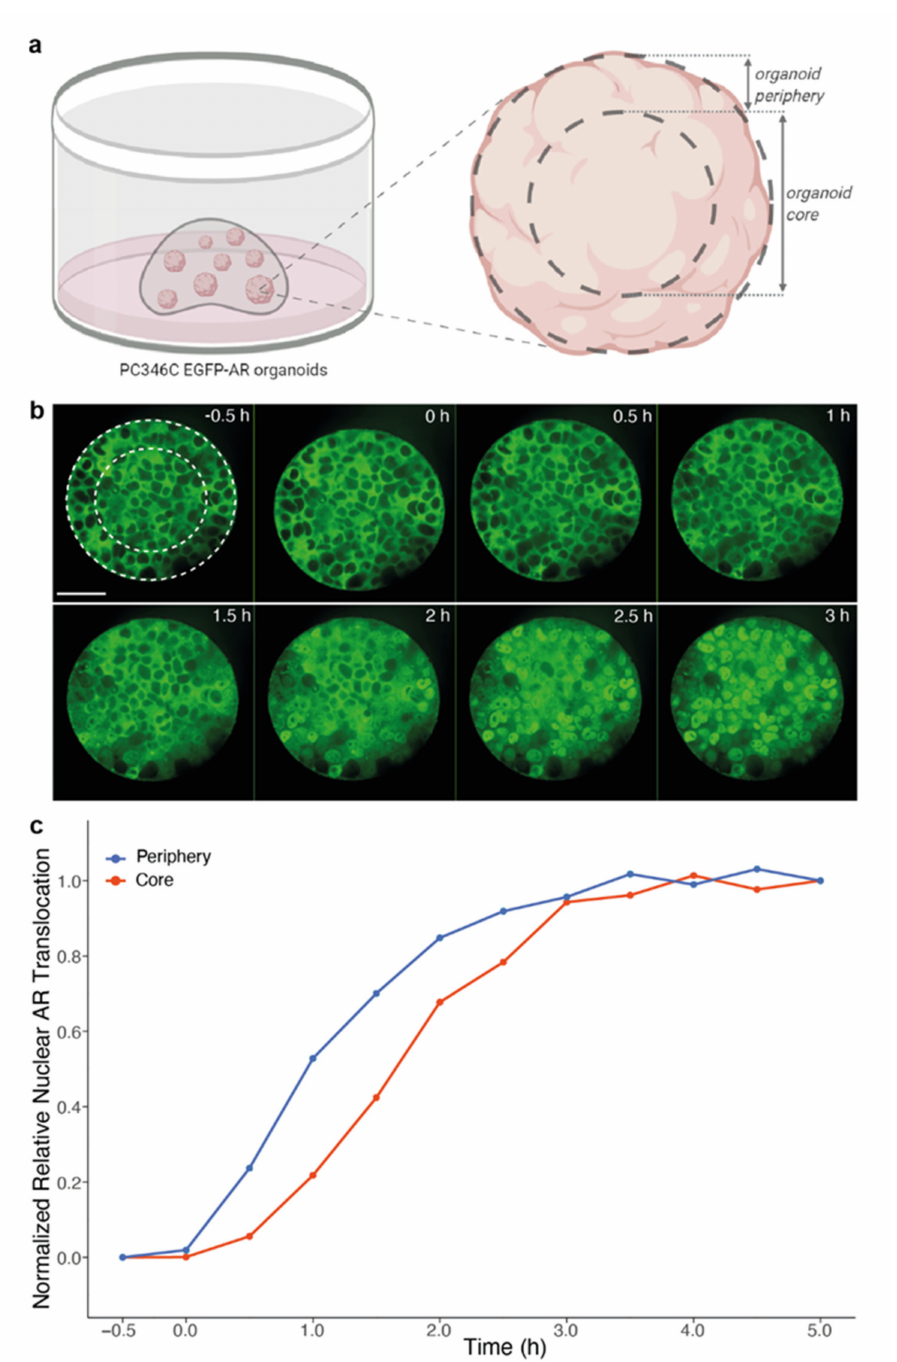
on the X position and Y position. White lines delineate the imaging field. Pink dots depict organoids, red dots are the organoids shown as example in ( c ). Gradient blue circle represents bins applied in ( d ). ( c ) Representative images of androgen-induced AR translocation in a PC346C EGFP-AR organoid located at the center (top panel) or edge (bottom panel) of the Matrigel dome following exposure to synthetic androgen (10 nM R1881). Time after exposure is indicated in the right upper corner of each image. Scale bars indicate 50 µ m. ( d ) Image-based quantification of nuclear AR translocation in organoid cells grouped in nine bins of ~250 µ m, based on the distance from the center of the well as depicted in ( b ). 10 nM R1881 was added to organoid medium at 0 h. Data points represent the average of four imaged wells.